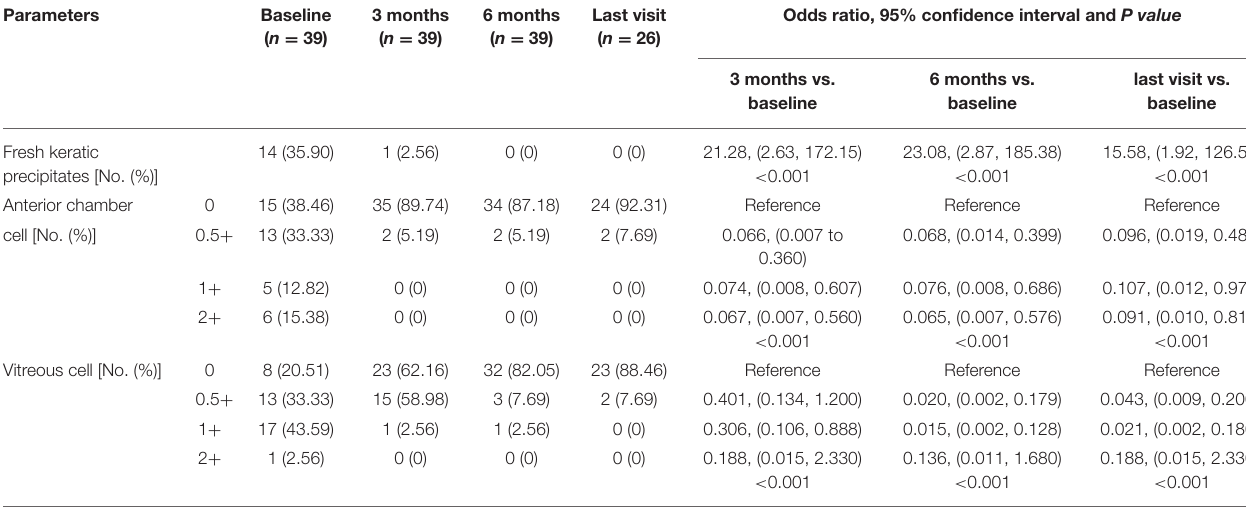
TABLE 3 | Main inflammatory outcomes under slit-lamp examination at baseline, 3, 6 months, and the last visit if longer than 6 months follow-up available after adalimumab initiation. Parameters Baseline